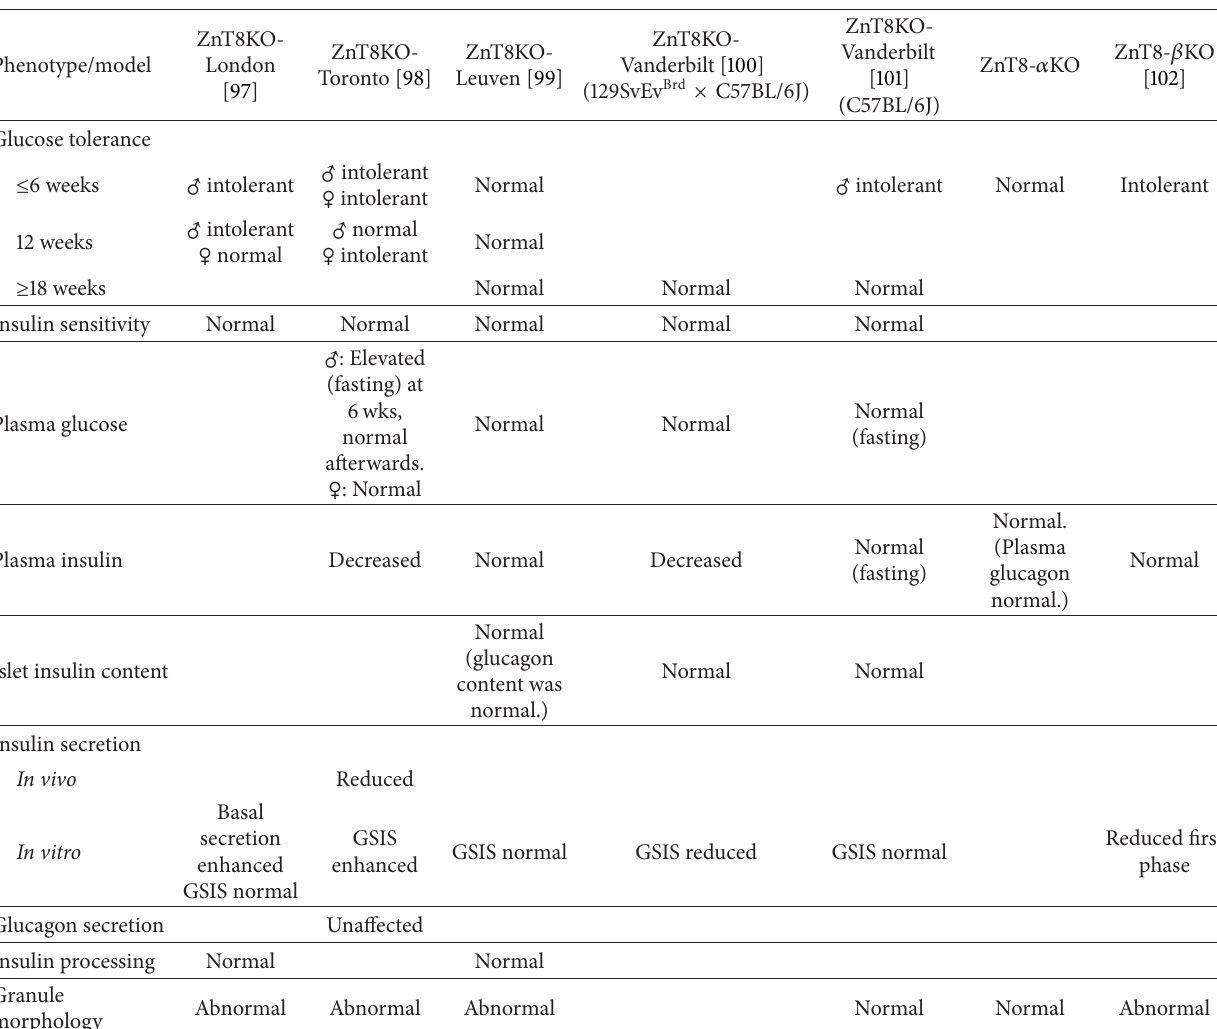
Table 1: Summary of the major phenotype of the different colonies of ZnT8 KO mice. ZnT8- 𝛼 KO and ZnT8- 𝛽 KO for 𝛼 and 𝛽 -cell-specific knockout mice, respectively; GSIS for glucose-stimulated insulin